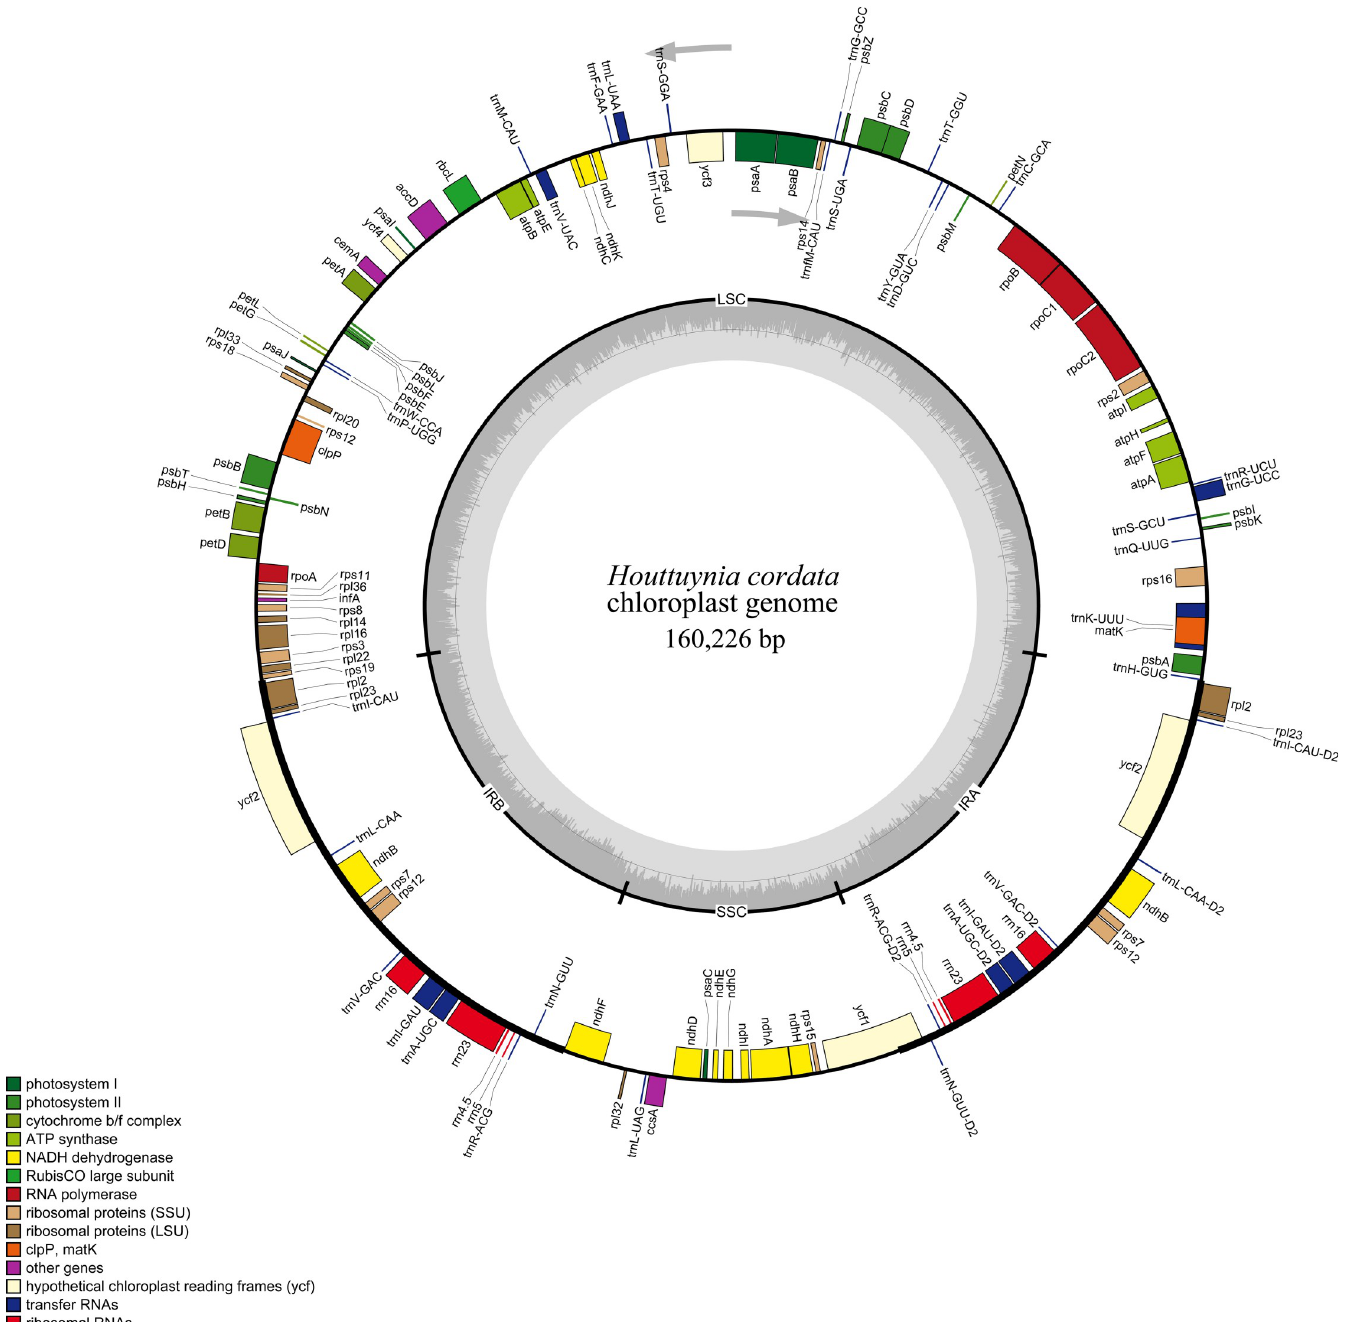
Fig 1. Gene circular map of the complete H . cordata cp genome. Genes on the outside and inside of the circle are transcribed in clockwise and counterclockwise directions, respectively. Genes belonging to different functional groups are color coded. Color intensity corresponds to GC content. The SSC, LSC, and inverted repeat regions (IRA and IRB) are